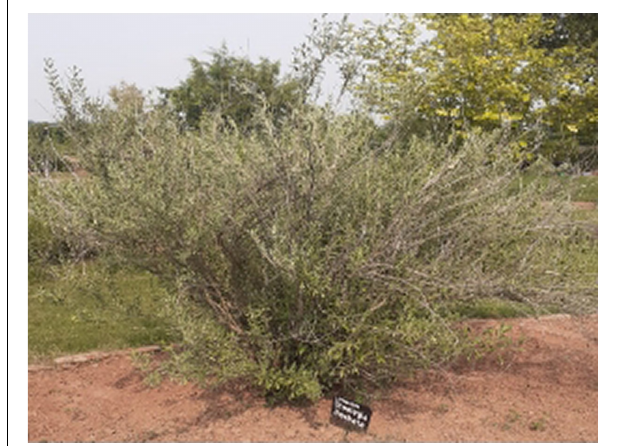
FIGURE 1 | Otostegia limbata